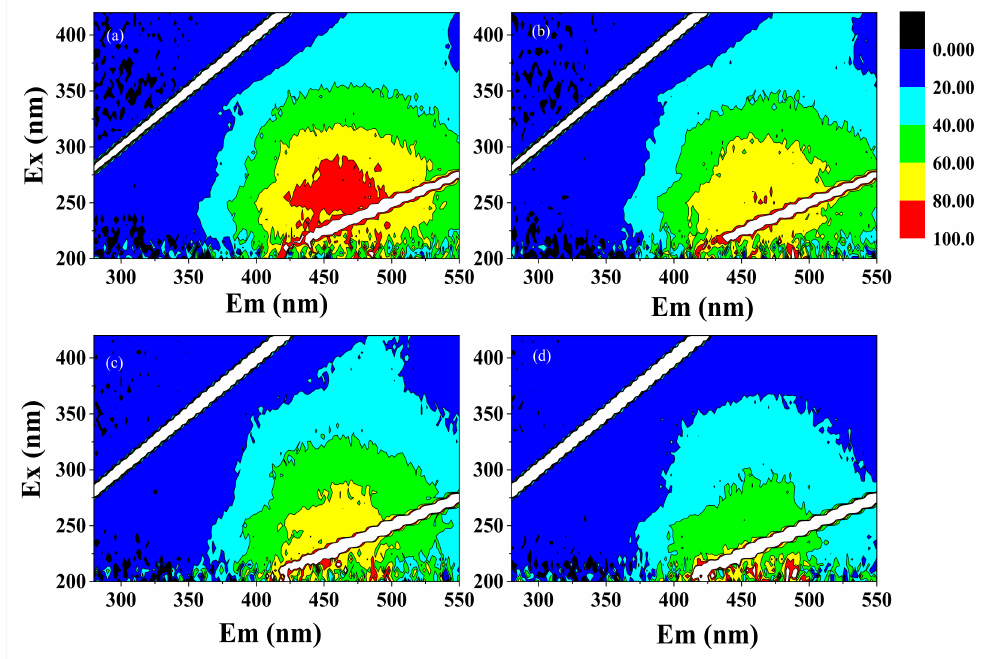
Figure 3. The fluorescence excitation-emission matrices obtained from different ratios of PM to BS. ( a ) 10:50 µ M: µ M, ( b ) 20:100 µ M: µ M, ( c ) 50:250 µ M: µ M and ( d ) 100:500 µ M: µ M. ((HA)o = 3 mg L − 1 and (PM)o:(BS)o = 10:50–100:500 µ M: µ